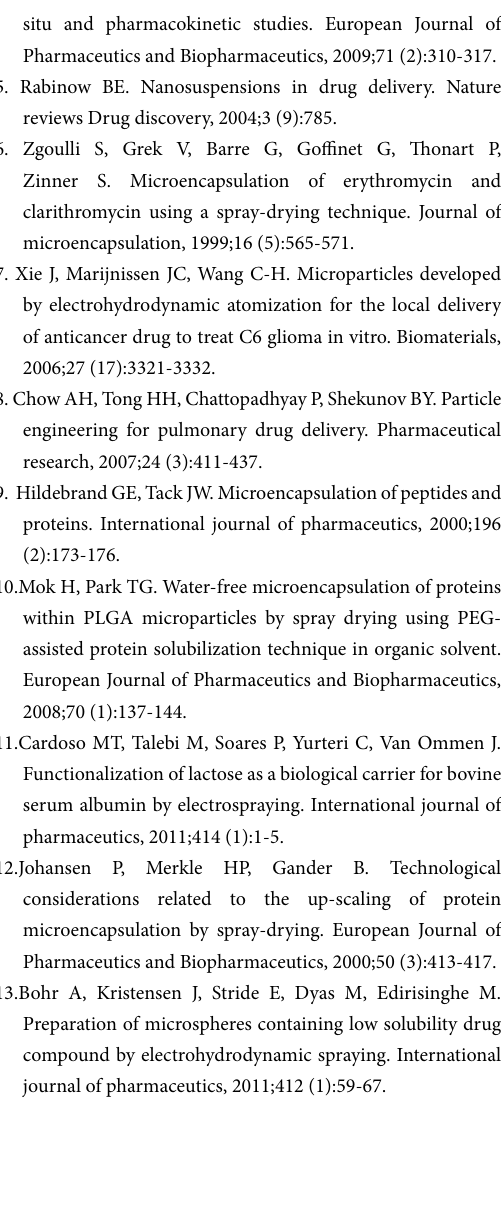
164 Nanomed Res J 2(3): 158-164,